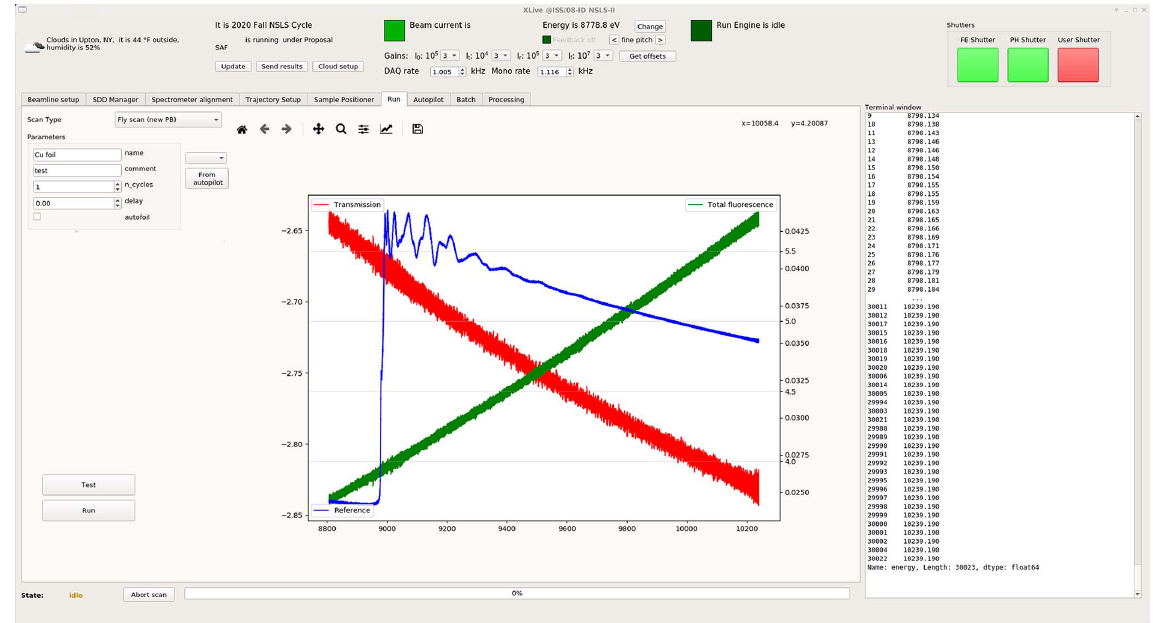
Figure 5 Screenshot of XLive software showing interpolated data from a Cu foil reference in the main plot. The central plot shows the raw transmission, fluorescence, and reference absorption signals that are obtained before binning, which is explained in the main text. Since only reference Cu foil was put into the beam, the reference channel is the only one showing a